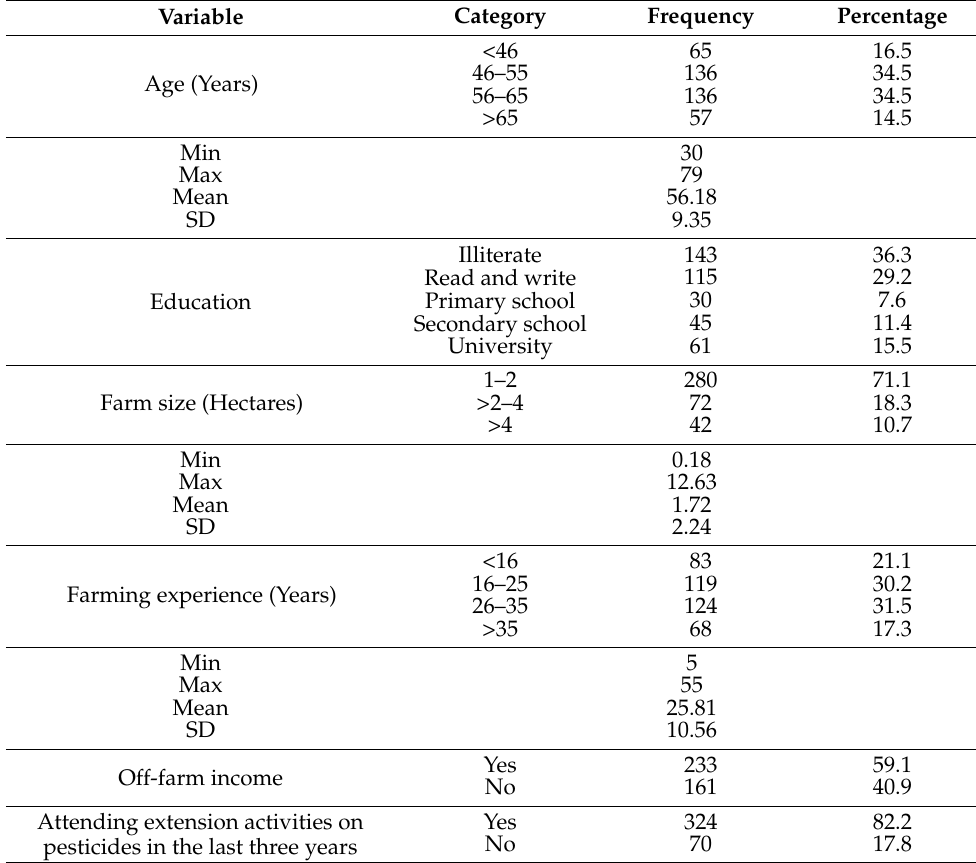
Table 1. Demographic characteristics of the